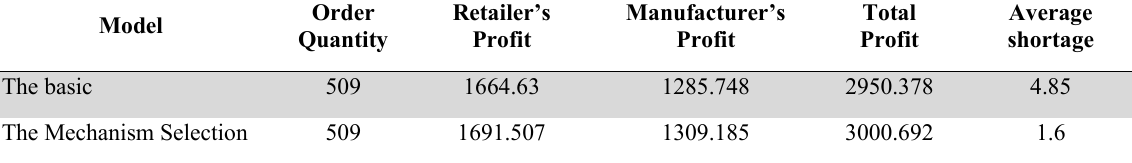
Outputs of the basic model and the mechanism selection